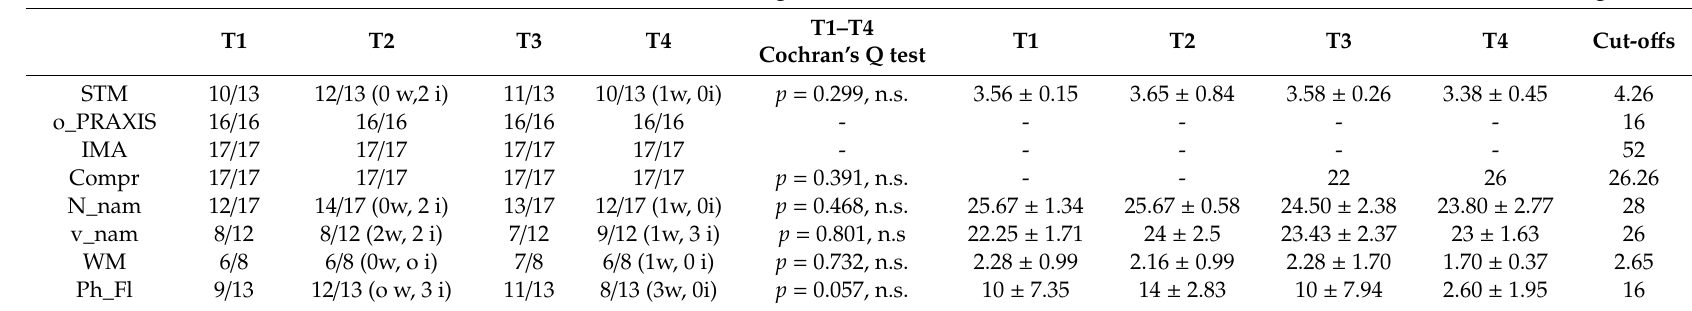
Table 5. Number of the 17 patients with recurrent glioma whose results were within the normal range at time points T1 and T2 (pre- and post-first surgery, respectively) and at T3 and T4 (pre- and post-recurrence surgery, respectively), with Cochran’s Q test of equality of proportions between the di ff erent times points. We stratified patients who decreased (w, normal range at T3 and below the normal range at T4), and improved (i, below the normal range at T3 but within the normal range at T4). The mean and s.d. below the normal patient range for patient performance (and the cut-o ff ) are shown in grey. To date, the level of performance in those patients was only slightly below the cut-o ff s (reported in the last column).